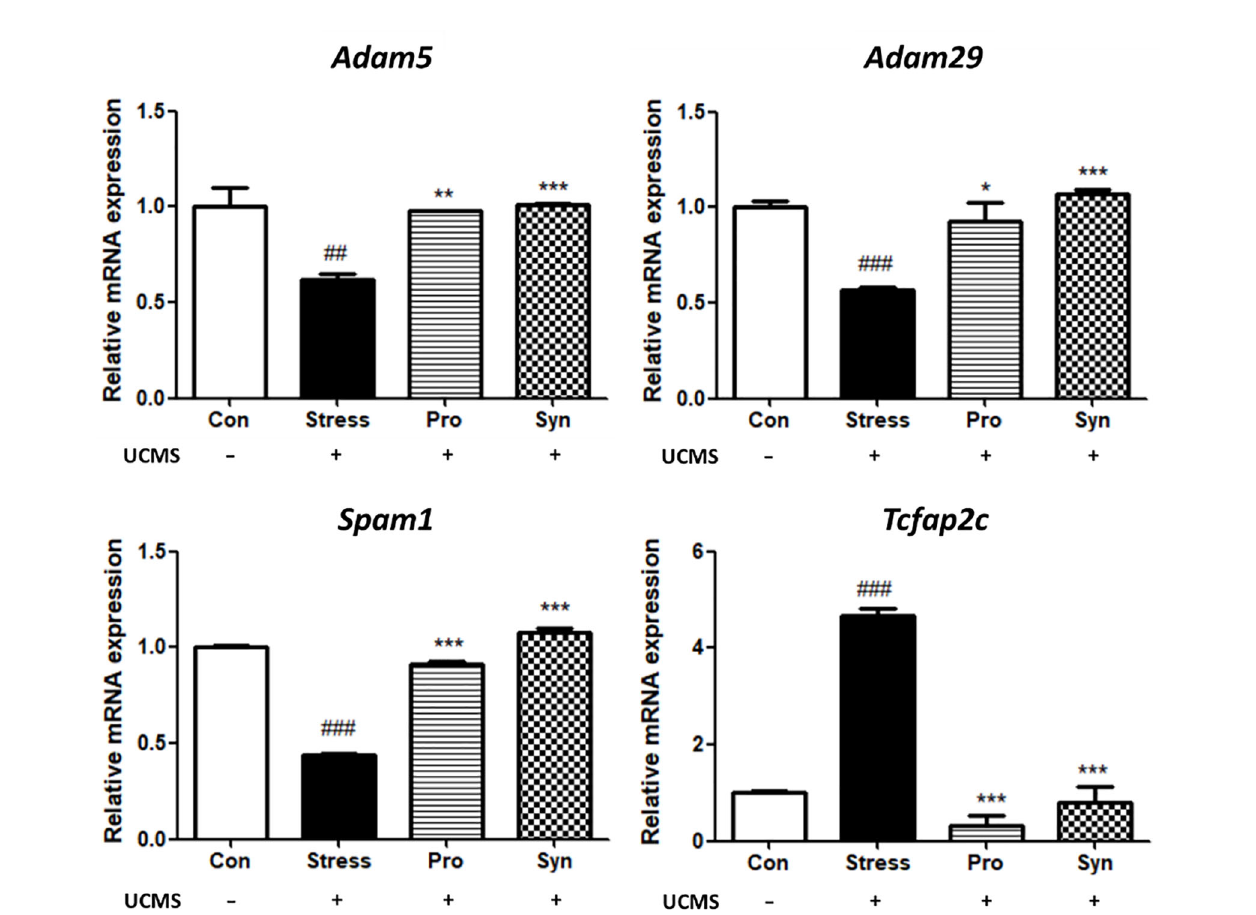
FIGURE 4 | Effects of probiotics and synbiotics treatments on the transcription of testicular development genes in mice testes under UCMS. Data represents the relative expression of Adam5 , Adam29 , Spam1 , and Tcfap2c compared to Gapdh . Data are expressedas themean ± SEM (n=12)from three independent experiments. # Signi fi cant differencecompared to the Con group( # p < 0.05, ## p < 0.005, ### p < 0.001). *Signi fi cant difference compared to the Stress group (* p < 0.05, ** p < 0.005, *** p <